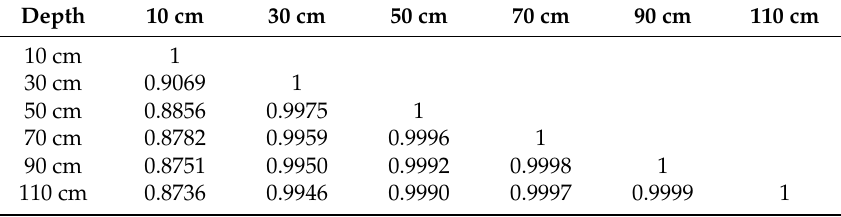
Table 3. Description of soil moisture variables at different depths in the soil profile. Number of classical refers to the categories divided for soil moisture variables in the soil profile; 2 refers to the two categories of soil moisture variables. Growing Stage